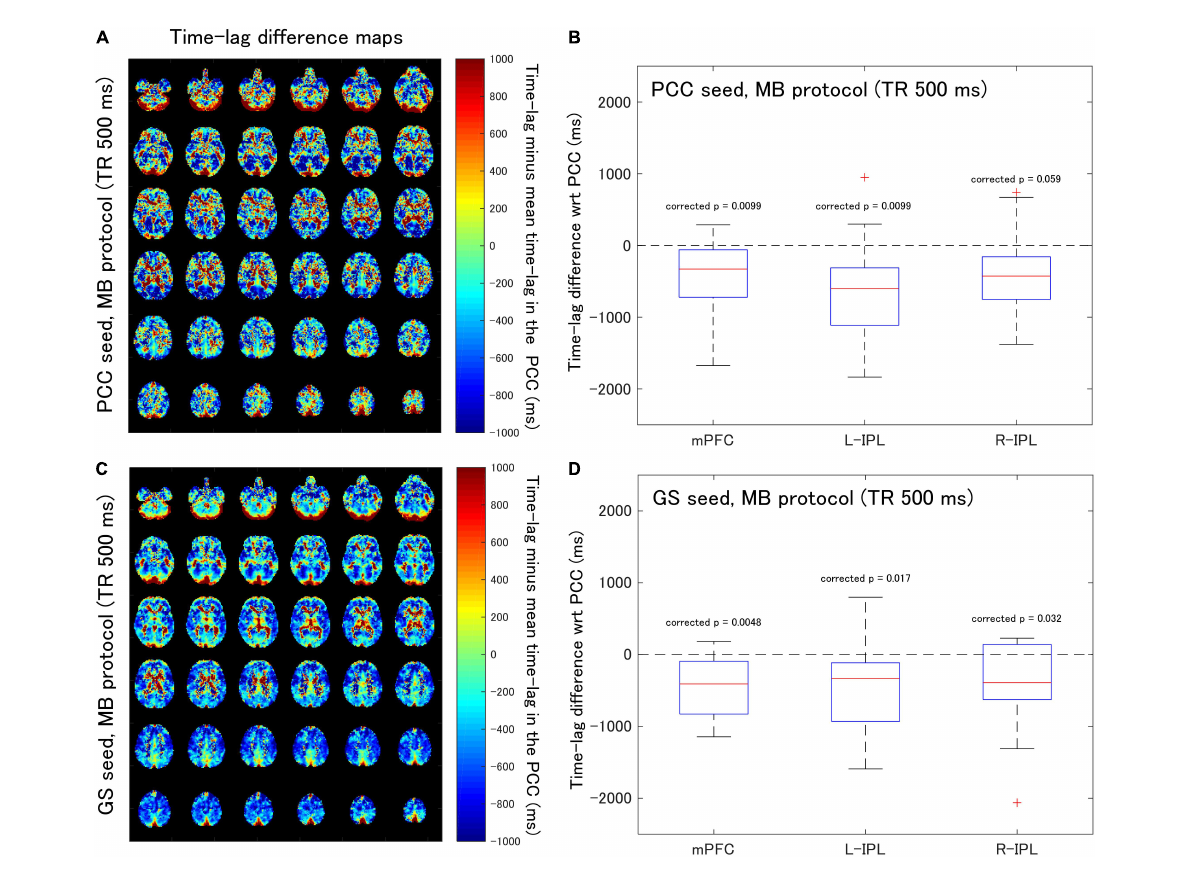
FIGURE3 Assessment of the difference in time-lag between the PCC and each of the DMN nodes for data acquired with the MB protocol (TR = 500 ms). Eighteen healthy female volunteers participated in this study. (A) Time-lag difference maps calculated using the PCC seed. (B) Box-whisker plots of the time-lag difference estimated using the PCC seed for each of the mPFC, L-IPL and R-IPL ROIs. (C) Time-lag difference maps calculated with the GS seed. (D) Box-whisker plots of the time-lag difference estimated using the GS seed for each of the mPFC, L-IPL and R-IPL